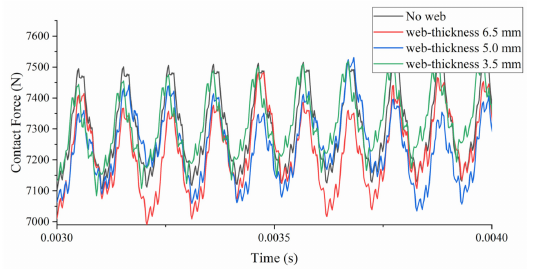
Figure 4. Contact forces of models with different web thickness.